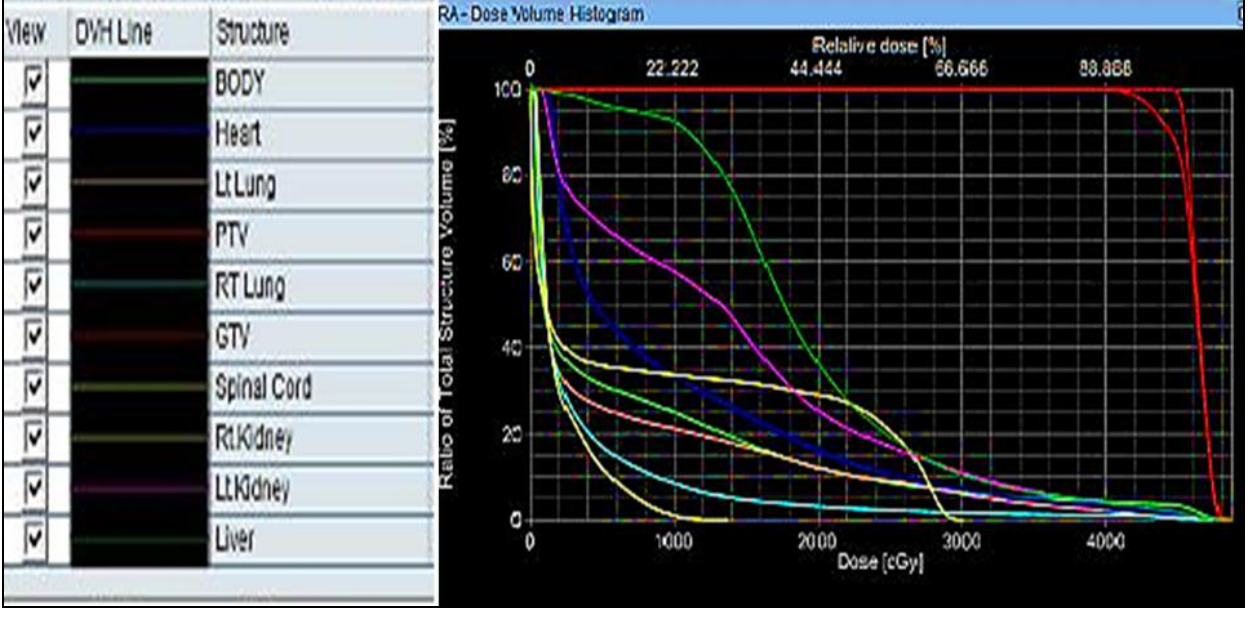
Figure 2: Dose volume histogram (DVH) parameters of IMRT Liver parameters : IMRT significantly